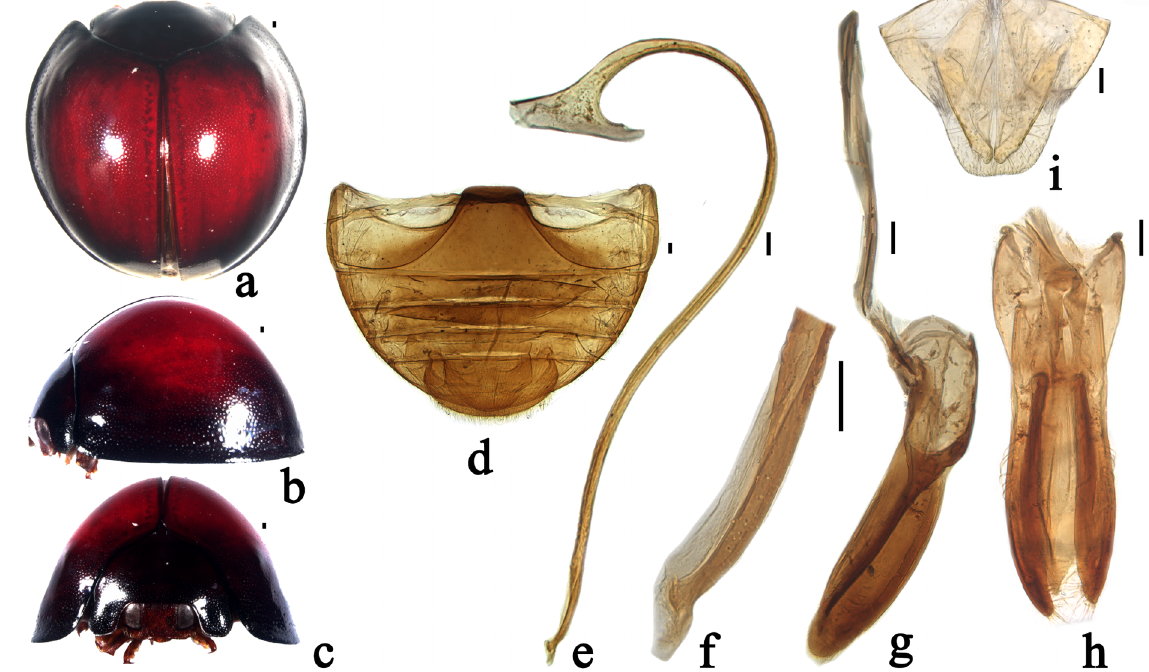
Fig. 7. Chilocorus chinensis Miyatake, 1970. a . Dorsal view. b . Lateral view. c . Frontal view. d . Abdomen. e . Penis. f . Apex of penis. g . Tegmen, lateral view. h . Tegmen, ventral view. i . Ovipositor. Scale bars: 0.1 mm.